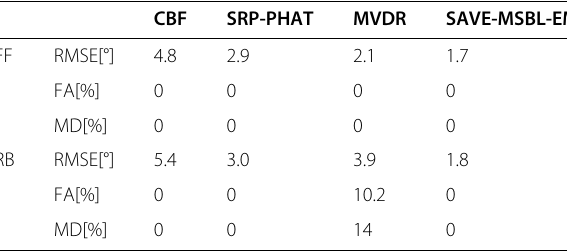
Table 2 Performance of all the methods for simulation